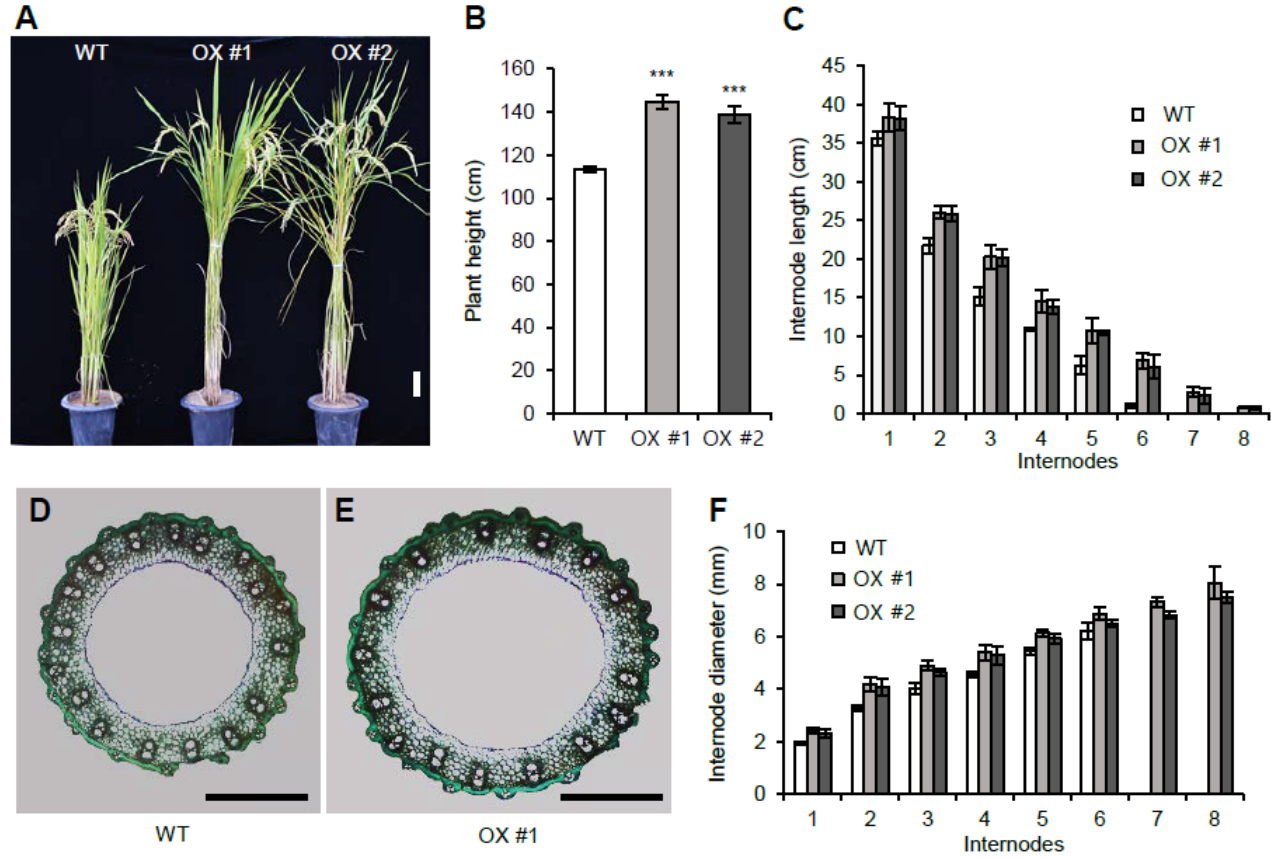
Figure 3. Internode development of wild-type (WT) and OsVIL1 overexpression (OX) transgenic plants. ( A ) Phenotypes at about 152 days after sowing (DAS) in the paddy field. Bar = 10 cm. ( B ) Plants height at about 152 DAS. ( C ) Comparison of each internode length at about 152 DAS. ( D , E ) Cross sections of the main culm from the first internode of the WT and OsVIL1 OX #1 transgenic line at about 112 DAS. Bars = 1 mm. ( F ) Comparison of the internode diameters at about 112 DAS. Error bars indicate the standard deviations, n = 4 or Statistical significance is indicated by *** ( p < 0.001).